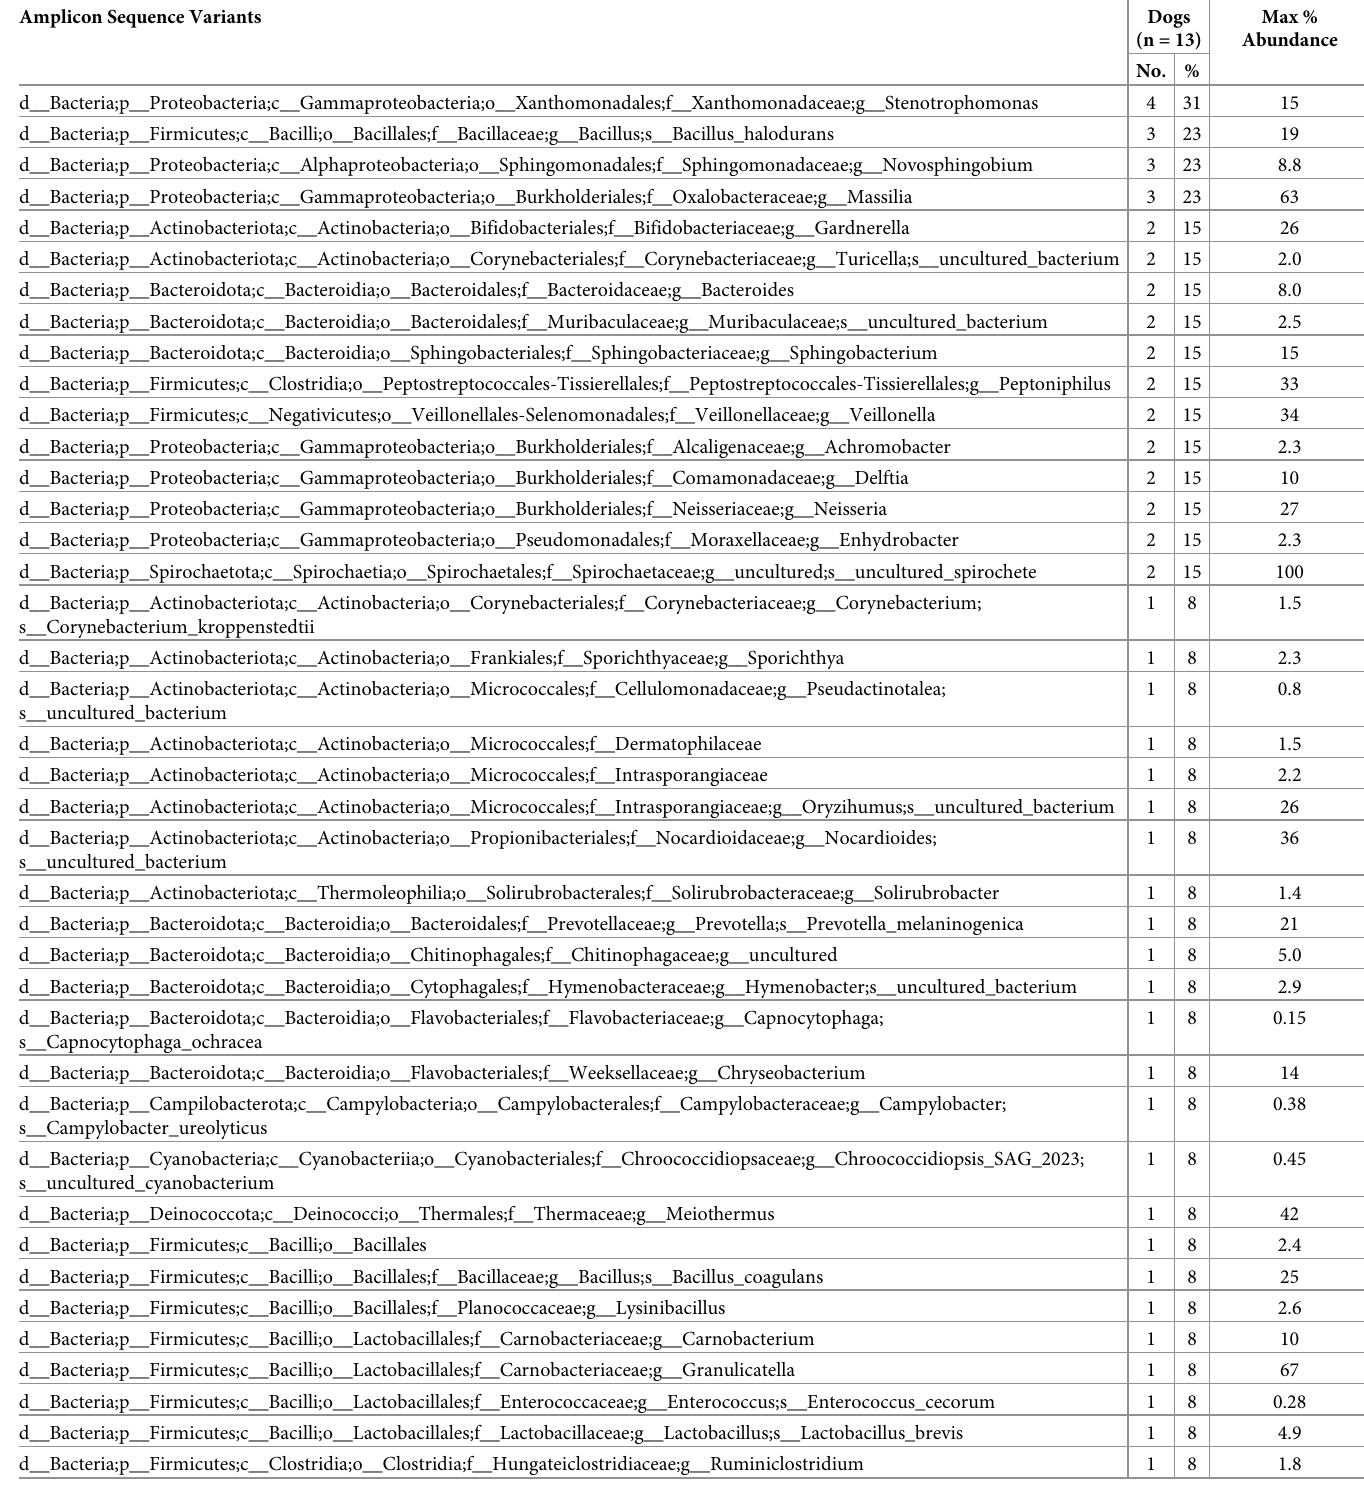
Table 1. Sixty-seven amplicon sequence variants amplified from bile collected from 13 apparently healthy adult dogs and not observed in extraction control samples not containing bile. Amplicon Sequence